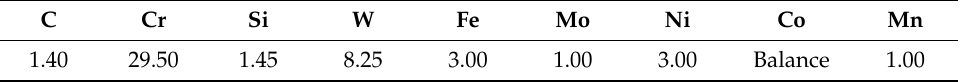
Table 1. Chemical composition (wt. %) of the tested Co